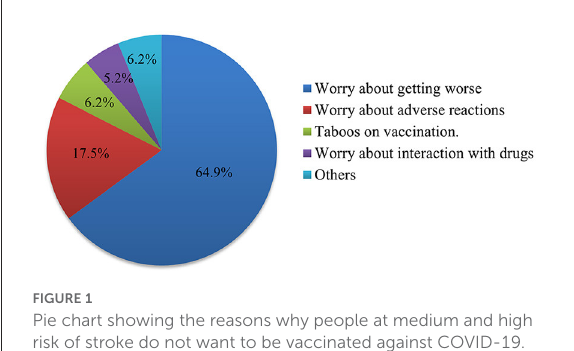
FIGURE1 Pie chart showing the reasons why people at medium and high risk of stroke do not want to be vaccinated against COVID-19. The number of each part of the pie chart represents the count and